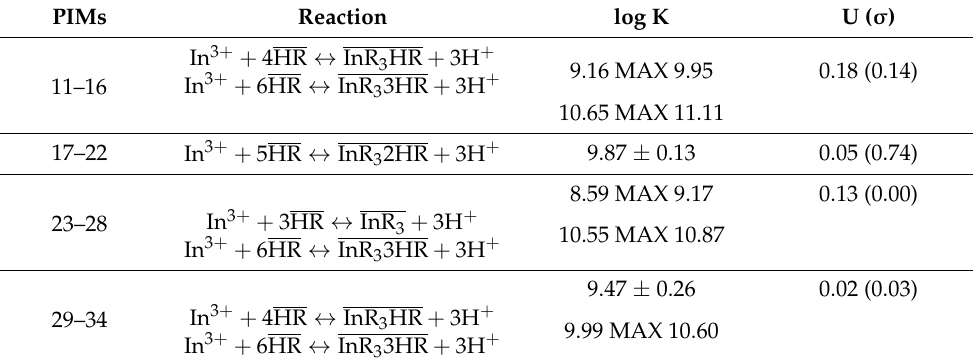
Table 3. Extraction reactions and their logarithm equilibrium constants for PIMs with 2NPOE (11–16 (low content) and 17–22 (high content)) and TBEP (23–28 (low content) and 29–33 (high content)) obtained after LETAGROP–DISTR analyses.